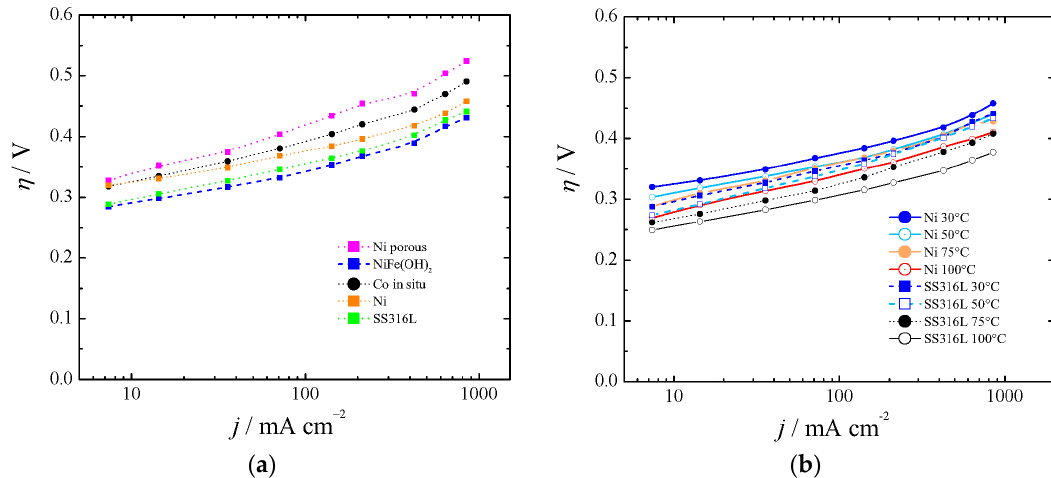
Figure 5. Polarization curves for the oxygen evolution reaction (OER) at ( a ) 30 ◦ C and ( b ) between 30 and 100 ◦